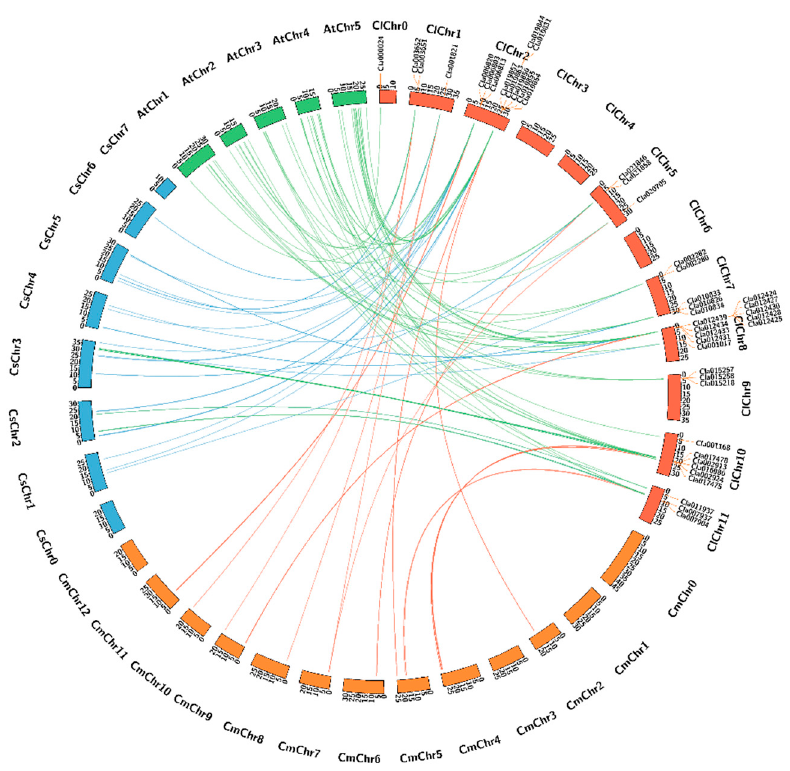
Figure 5. Microsynteny analysis of the 44 watermelon NBS-encoding R genes compared to those of Cucumis melo , Cucumis sativus and A. thaliana . Brown orange, blue and green indicate C. lanatus , Cucumis melo , Cucumis sativus and A. thaliana chromosomes, respectively.